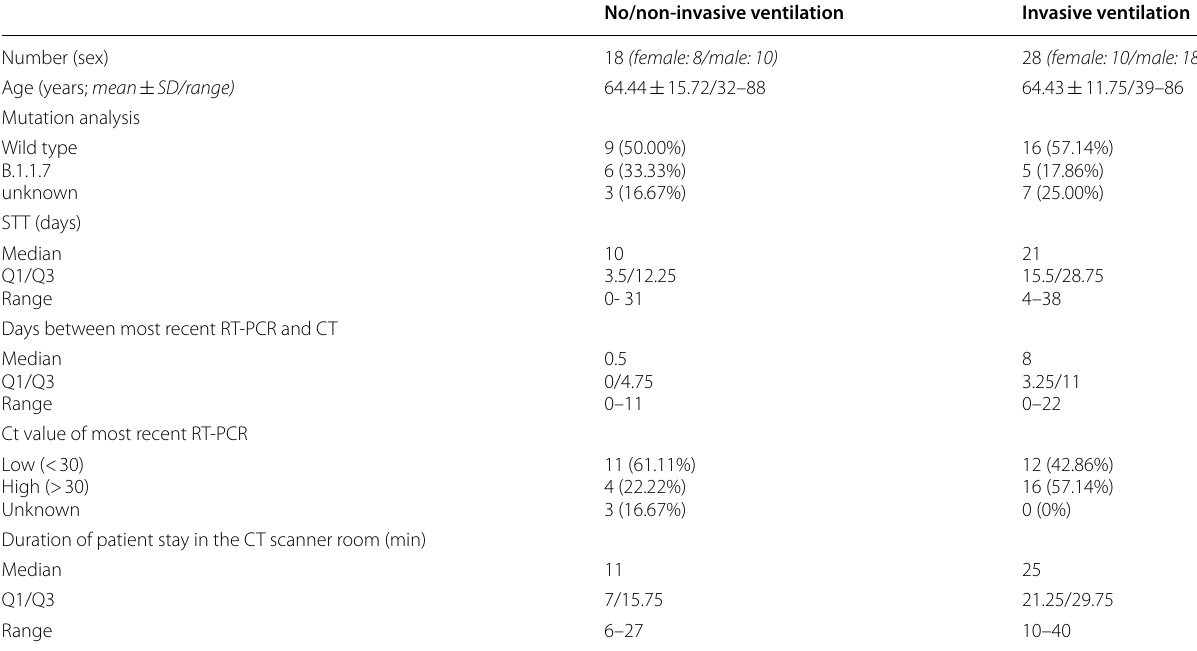
Wild type: SARS-CoV-2 wild type; B1.1.7: SARS-CoV-2 variant of concern; STT: symptom to test time–time between symptom onset and CT examination; Q1: first quartile, Q3: third quartile, RT-PCR: reverse-transcription polymerase chain reaction; Ct value: RT-PCR cycle threshold